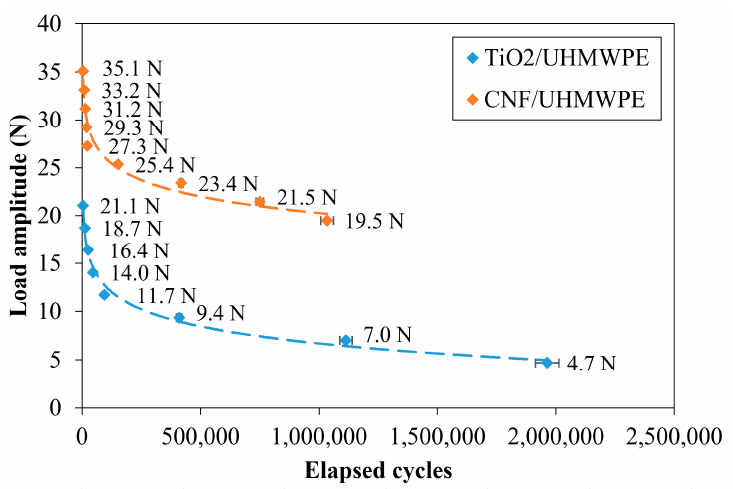
Figure 8. Comparison of the Whöler curve of the two CNF/UHMWPE and TiO 2 /UHMWPE SLJs.